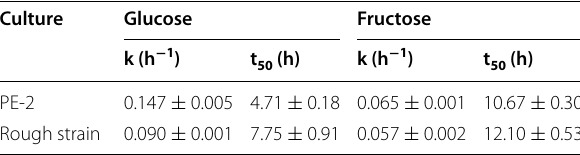
Results are the mean